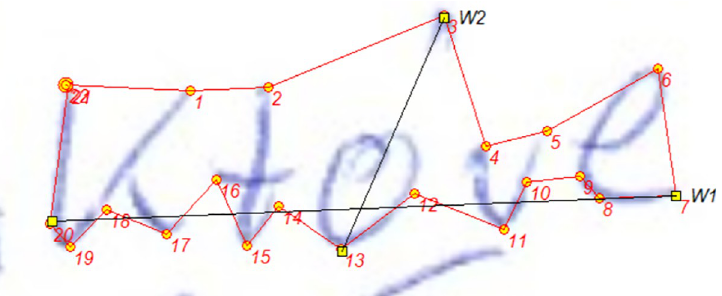
Fig 1. The example of examination with the use of Grafotyp software. Estimation of perimeter (red line between digits 1 and 22), surface of the specimen (the inner part surrounded by a red line), and other parameters such as size proportion (digits denote the order of marking spots, and sections W2 and W1 are necessary to determine the size proportion of the